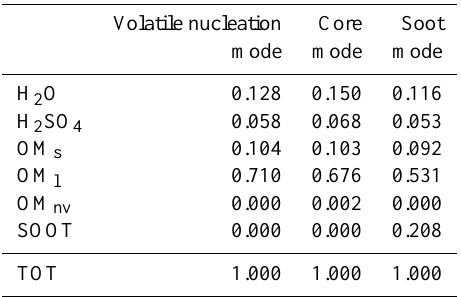
Table 4. Mass fractions of particle components at 2.7s obtained from simulation by MAFOR with initial GSA = 2 × 10 12 cm − 3 . OM s , OM l and OM nv refer to semi-volatile, low volatile and non- volatile organic